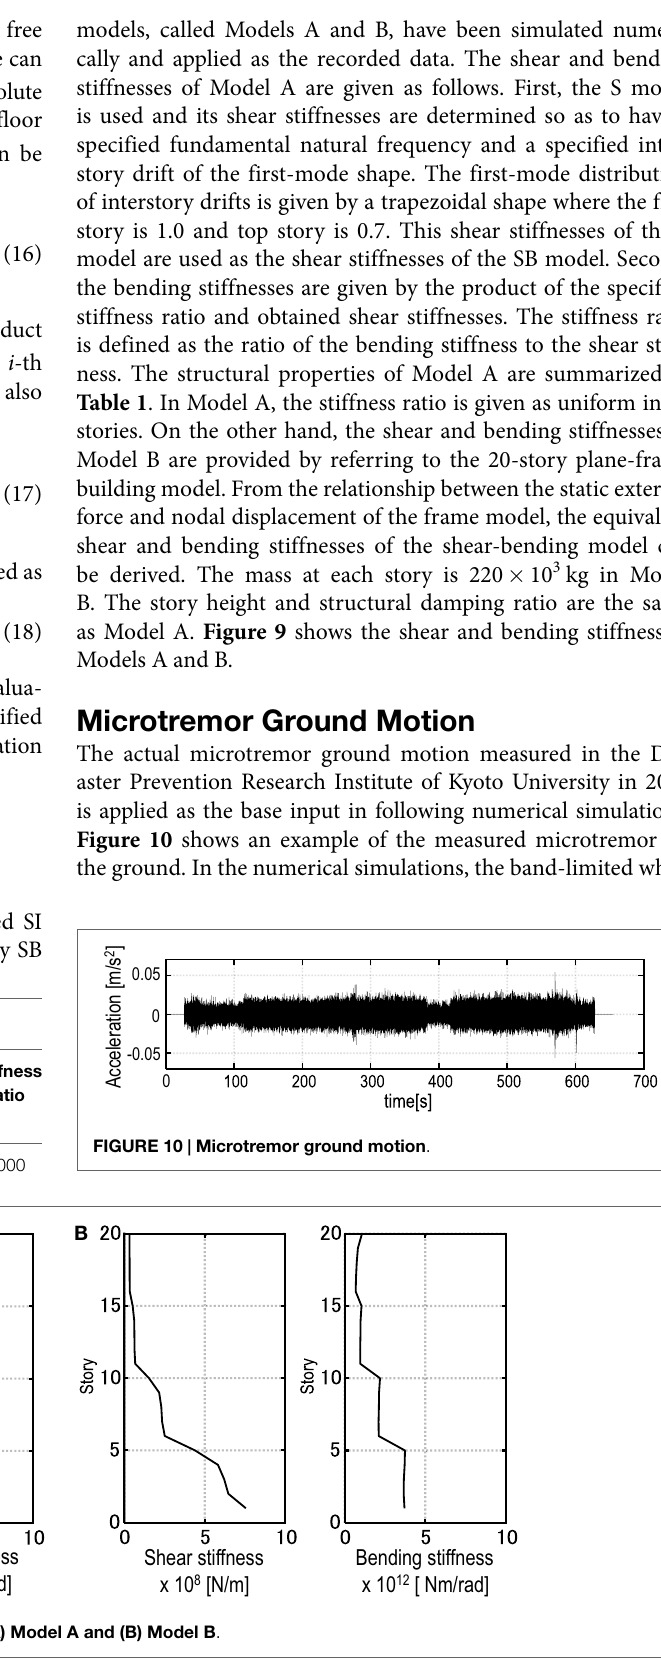
Frontiers in Built Environment |